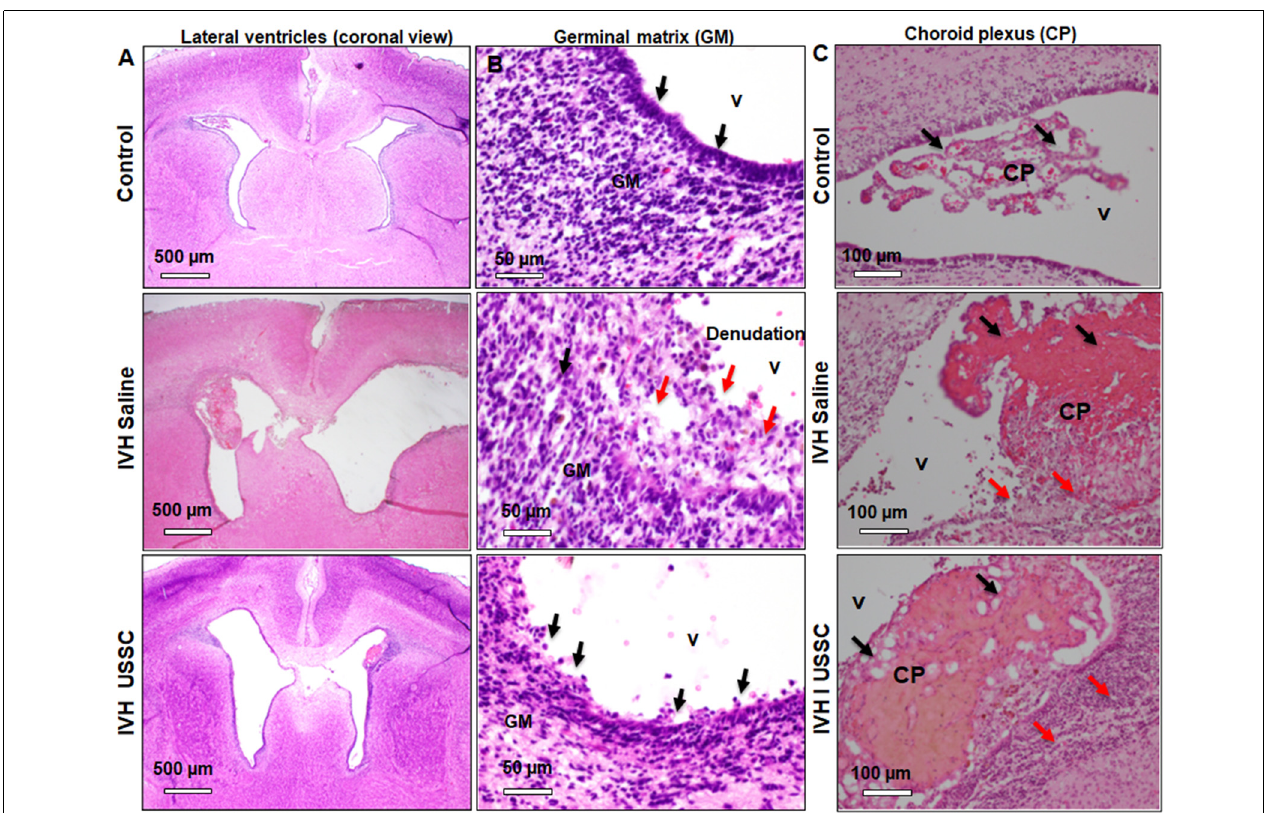
FIGURE 2 | Histopathological recovery after USSC administration in germinal matrix and choroid plexus in the lateral ventricles after PHH. (A,B) Representative H&E stained coronal sections at the level of mid-septal nucleus after USSC administration. Note: the normal intact ependymal wall in control low power (black arrow, top panel- A ; 4 × ) and high power (top panel- B ; 20 × ) vs. the damaged wall after IVH (red arrow middle panel A ; 4 × and panel- B ; 20 × ). Compare effects after USSC injection showing recovered germinal matrix (bottom panel A and B ; 4 × and 20 × images). The arrow shows normal and damaged areas. The Scale bar for panel (A) 500 µ m and for panel (B) is 50 µ m. (C) Representative H&E stained coronal section with choroid plexus showing normal intact choroid epithelium in control shown in black arrow (top panel- C ; 20 × ), damaged choroid plexus (CP) filled with blood shown in black arrow, histiocytic and damaged epithelium in IVH (middle image panel– C ; 20 × ) compare to effects of USSC injection showing partial recovery in the CP (panel- C ; 20 × image). The arrow shows normal vs. damaged areas. The scale bar for all images is 100 µ m, USSC: 2 × 10 6 cells/dose. All images were taken using Olympus microscope model BX43F (Olympus Corporation-Life